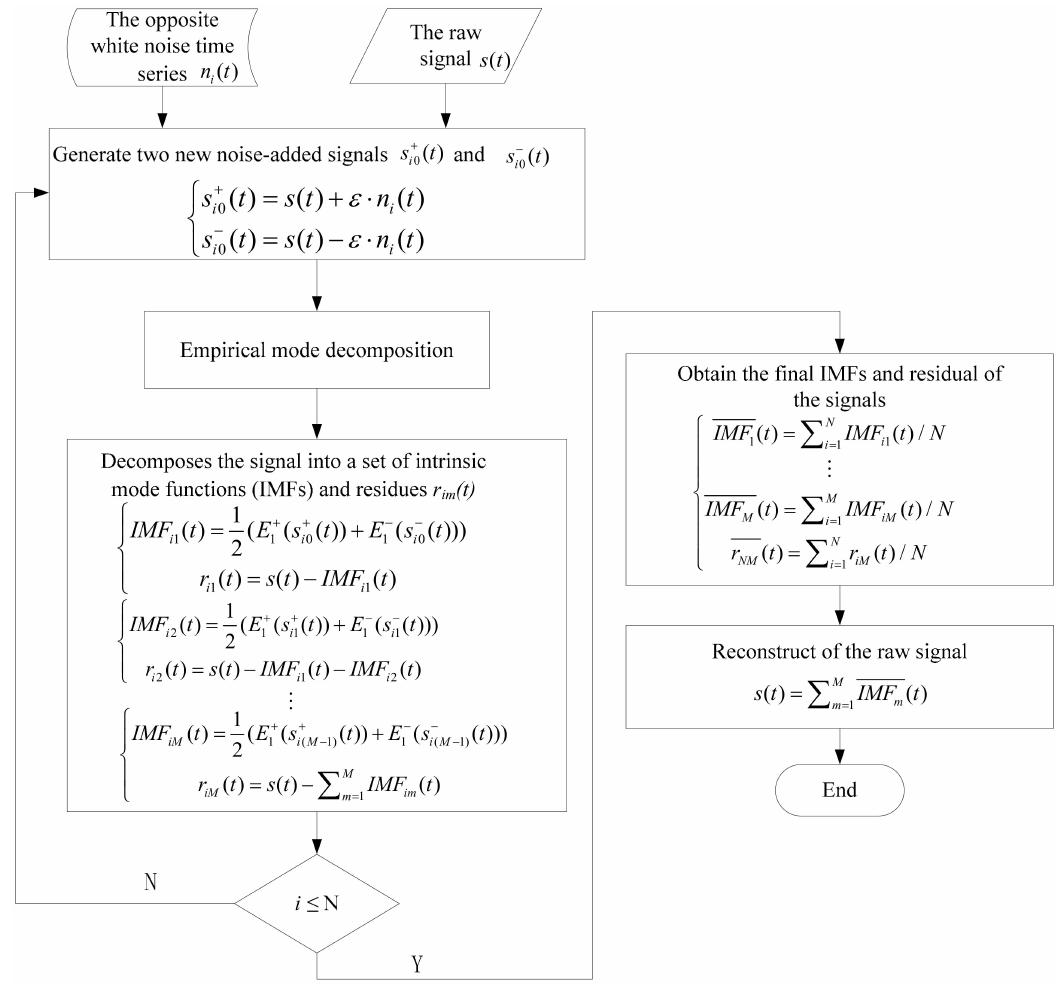
Figure 2. The flow chart of complementary ensemble empirical mode decomposition (CEEMD) preprocess for multi-sensor